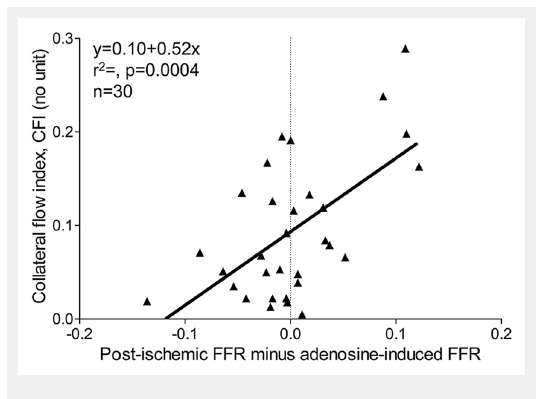
Coronary angiograms of the balloon-occluded right coronary artery (RCA, left upper panel), of the patent RCA with an ostial stenosis (mid upper panel) and showing part of the distal left circumflex coronary artery (arrow); the upper right panel depicts a left coronary angiogram with an identical trace of the distal left circumflex artery as shown in the mid upper panel. The pressure and ECG tracings are recorded during ostial RCA balloon occlusion: mean (P ao ) and phasic aortic pressure in black, mean (P occl ) and phasic coronary occlusive pressure in red, central venous pressure (CVP) in blue, intracoronary ECG. FFR = fractional flow reserve as P occl /P ao .